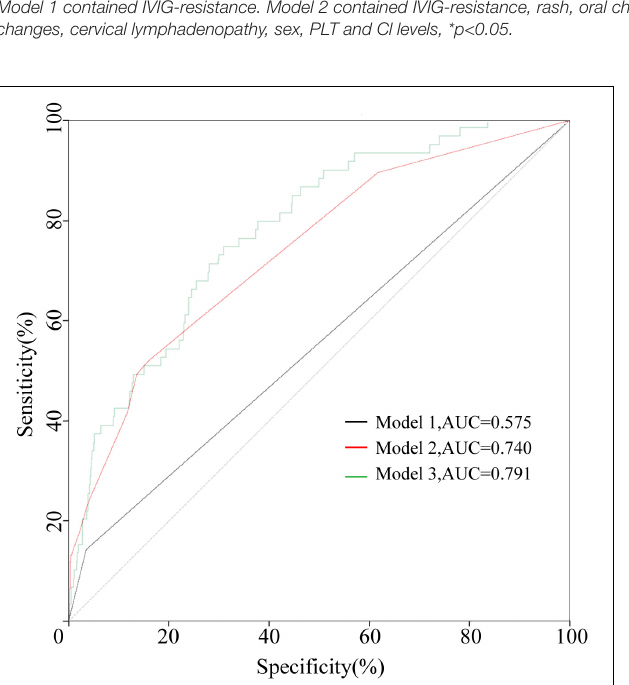
FIGURE 3 | The ROC curve of Model 2 in the validation cohort. Model 2 contained IVIG resistance, rash, oral changes, and cervical lymphadenopathy. according to sex and CAA status and focused on the distribution of rash, oral changes, and cervical lymphadenopathy